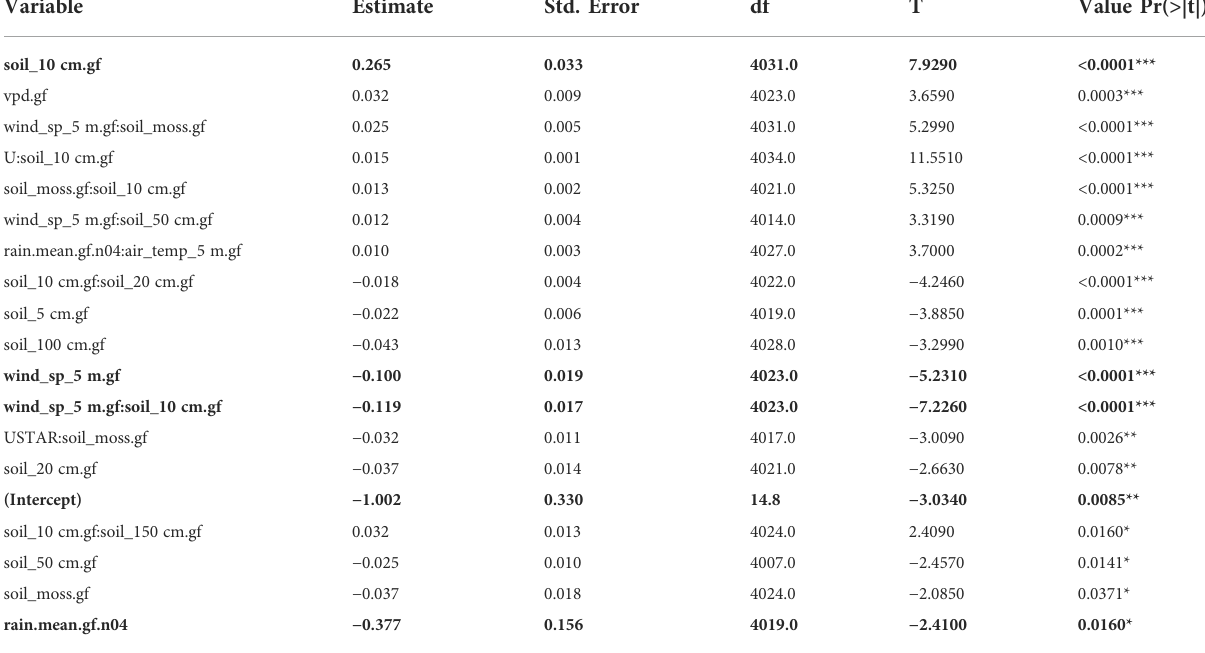
TABLE1LinearmixedeffectmodelforCO 2 fl uxduringtheTooliklakeice-freeseasons2010 – 2015.Predictorvariablesaggregatedto3-haveragesor sums (rainfall) were normalized to look at relative importance (estimate of response slopes). Insigni fi cant effects and those in fl uencing CO 2 fl ux by less than ± 1% are not included. Effects in fl uencing CO 2 fl ux by more than ± 10% are shown with bold face font. Stepwise forward selection was used to fi nd the best model. Fixed effects were sorted within each signi fi cance level according to their relative importance (Estimate).